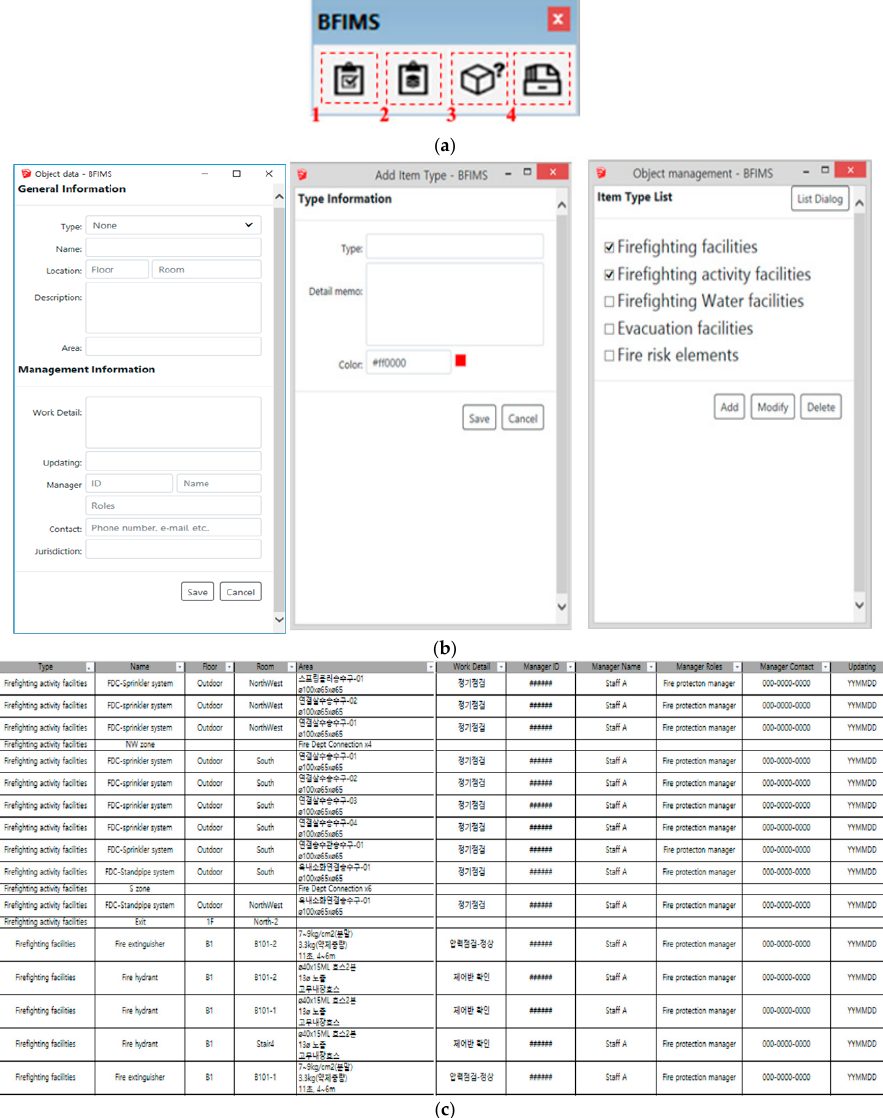
Figure 4. Examples of the BFIMS screenshot. ( a ) Graphic User Interface (GUI) module icons in